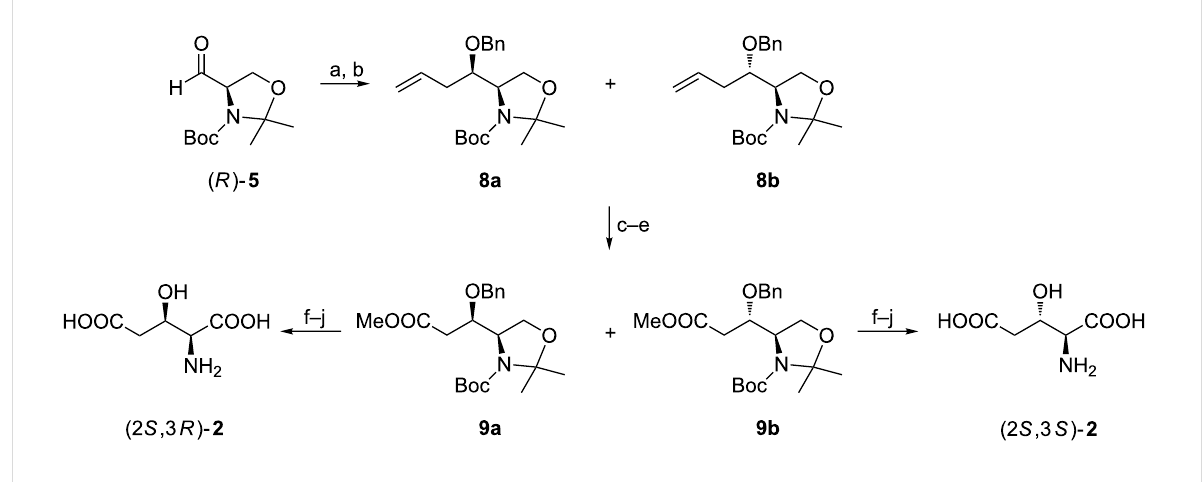
Scheme 2: Synthesis of (2 S ,3 R )- 2 and (2 S ,3 S )- 2 from ( R )-Garner’s aldehyde. Reagents and conditions: a) H 2 C=CHCH 2 MgCl, ZnCl 2 , THF; b) BnBr, NaH, THF; c) 4-methylmorpholine N -oxide, OsO 4 , dioxane/water; d) NaIO 4 , then NaOCl 2 , H 2 NSO 3 H; e) MeI, K 2 CO 3 , acetone; f) AcOH, H 2 O;